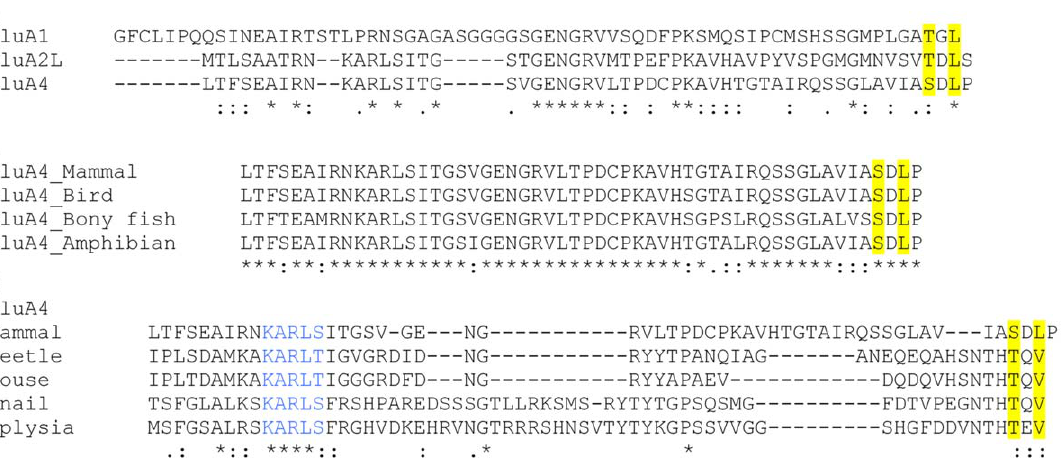
Figure 1. Sequence characteristics of long-tailed AMPA receptor subunits. (A) Alignment of the unique carboxyterminal extensions of rat long-tailed GluA1, GluA2 L and GluA4 subunits. The accession codes (SwissProt/TrEMBL) for the sequences are: GluA1, P19490; GluA4, P19493; GluA2 L , P23819-3. (B) Conservation of GluA4 C-terminal sequence in vertebrate evolution. The indicated GluA4 orthologs represent diverse vertebrate lineages: mammals ( Rattus norvegicus , rat, P19490), birds ( Gallus gallus , chicken, Q90858), bony fishes ( Danio rerio , zebra fish, Q71E58) and amphibians ( Xenopus tropicalis , western clawed frog; the sequence represents a virtual translation of Genbank EST CX366243). (C) Alignment of mammalian GluA4 carboxyterminal sequence with its closest invertebrate homologs: Mammal (rat); Beetle, ( Tribolium castaneum , Red flour beetle, XP 968786); Louse, ( Pediculus humanus corporis , human body louse, XP 002430327); Snail ( Lymnaea stagnalis , great pond snail, CAA42683); Aplysia ( Aplysia californica , California sea har, ABB03888). In all alignments, the residues conforming to the class I PDZ motif (-Thr/Ser-X- W ; W denoting an amino acid residue with large aliphatic side chain, X standing for any amino acid) are highlighted in yellow. Asterisks indicate identical residues, whereas strong and weak similarities (according to Gonnet Pam250 matrix [49]) are indicated by colons and dots,